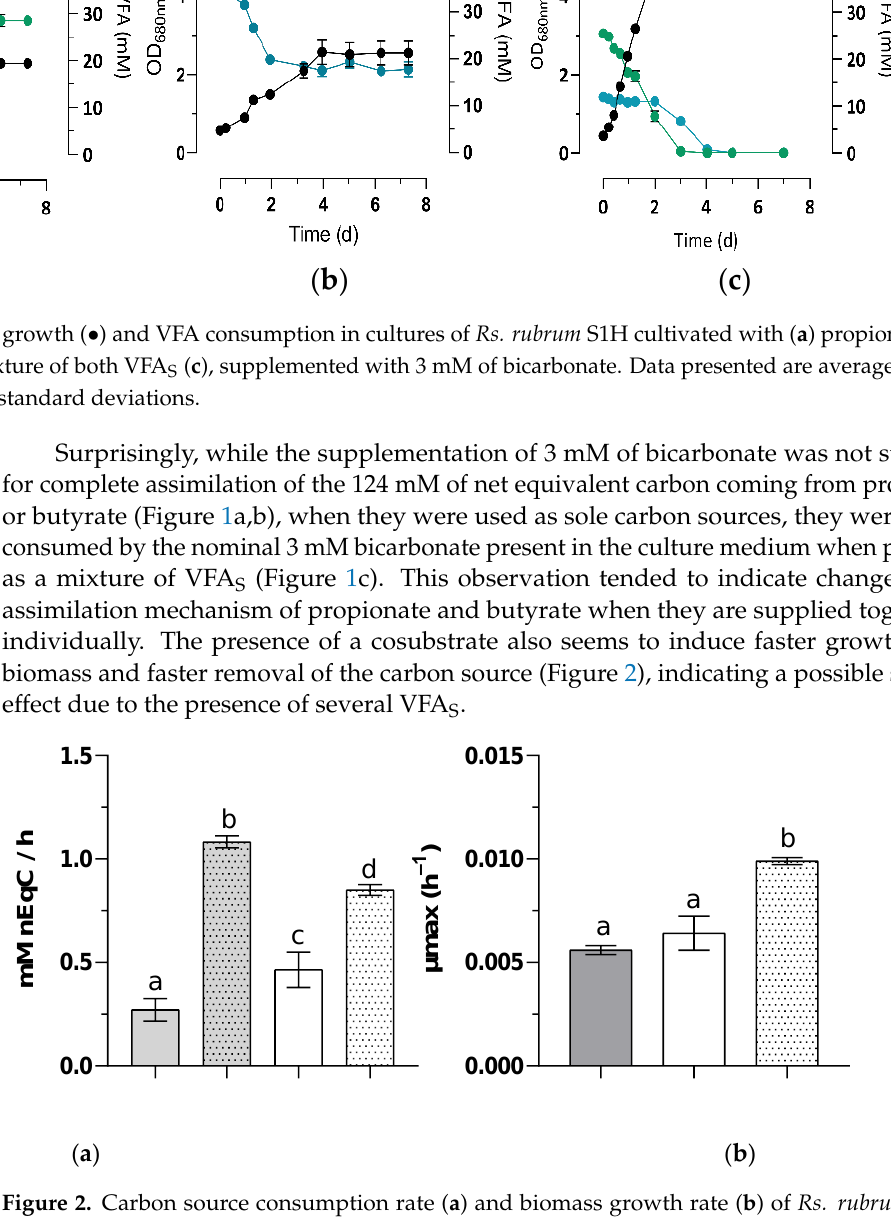
Figure 2. Carbon source consumption rate ( a ) and biomass growth rate ( b ) of Rs. rubrum grown using propionate ( ■ ), butyrate (□), or a mixture of these VFA S ( ) as the carbon source (n = 5).